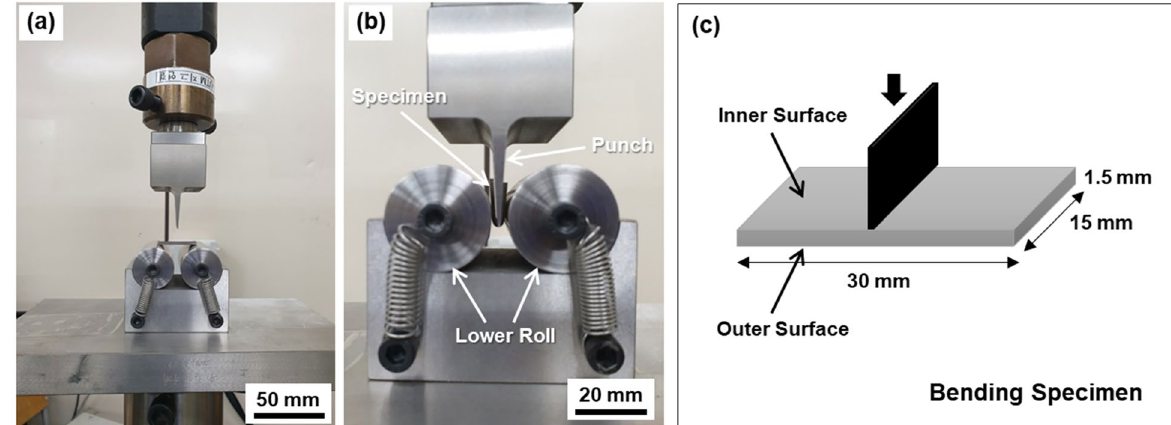
Figure 11. ( a , b ) Photographs of the three-point bending test set-up composed of punch, lower rolls, and bending specimen and ( c ) shape and dimensions of test